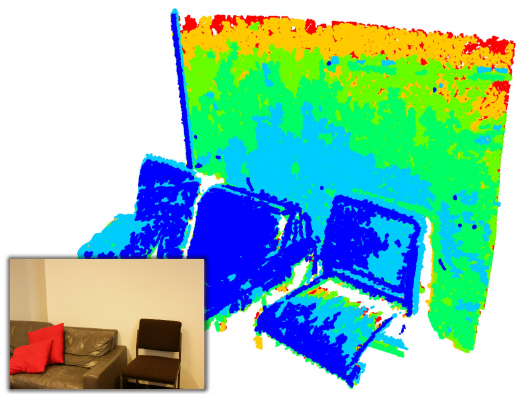
Figure 1. Exemplary reconstruction: 3D points are color coded depending on how many images per viewpoint were at least nec- essary for their reconstruction ( 1ˆ= blue to 30ˆ=